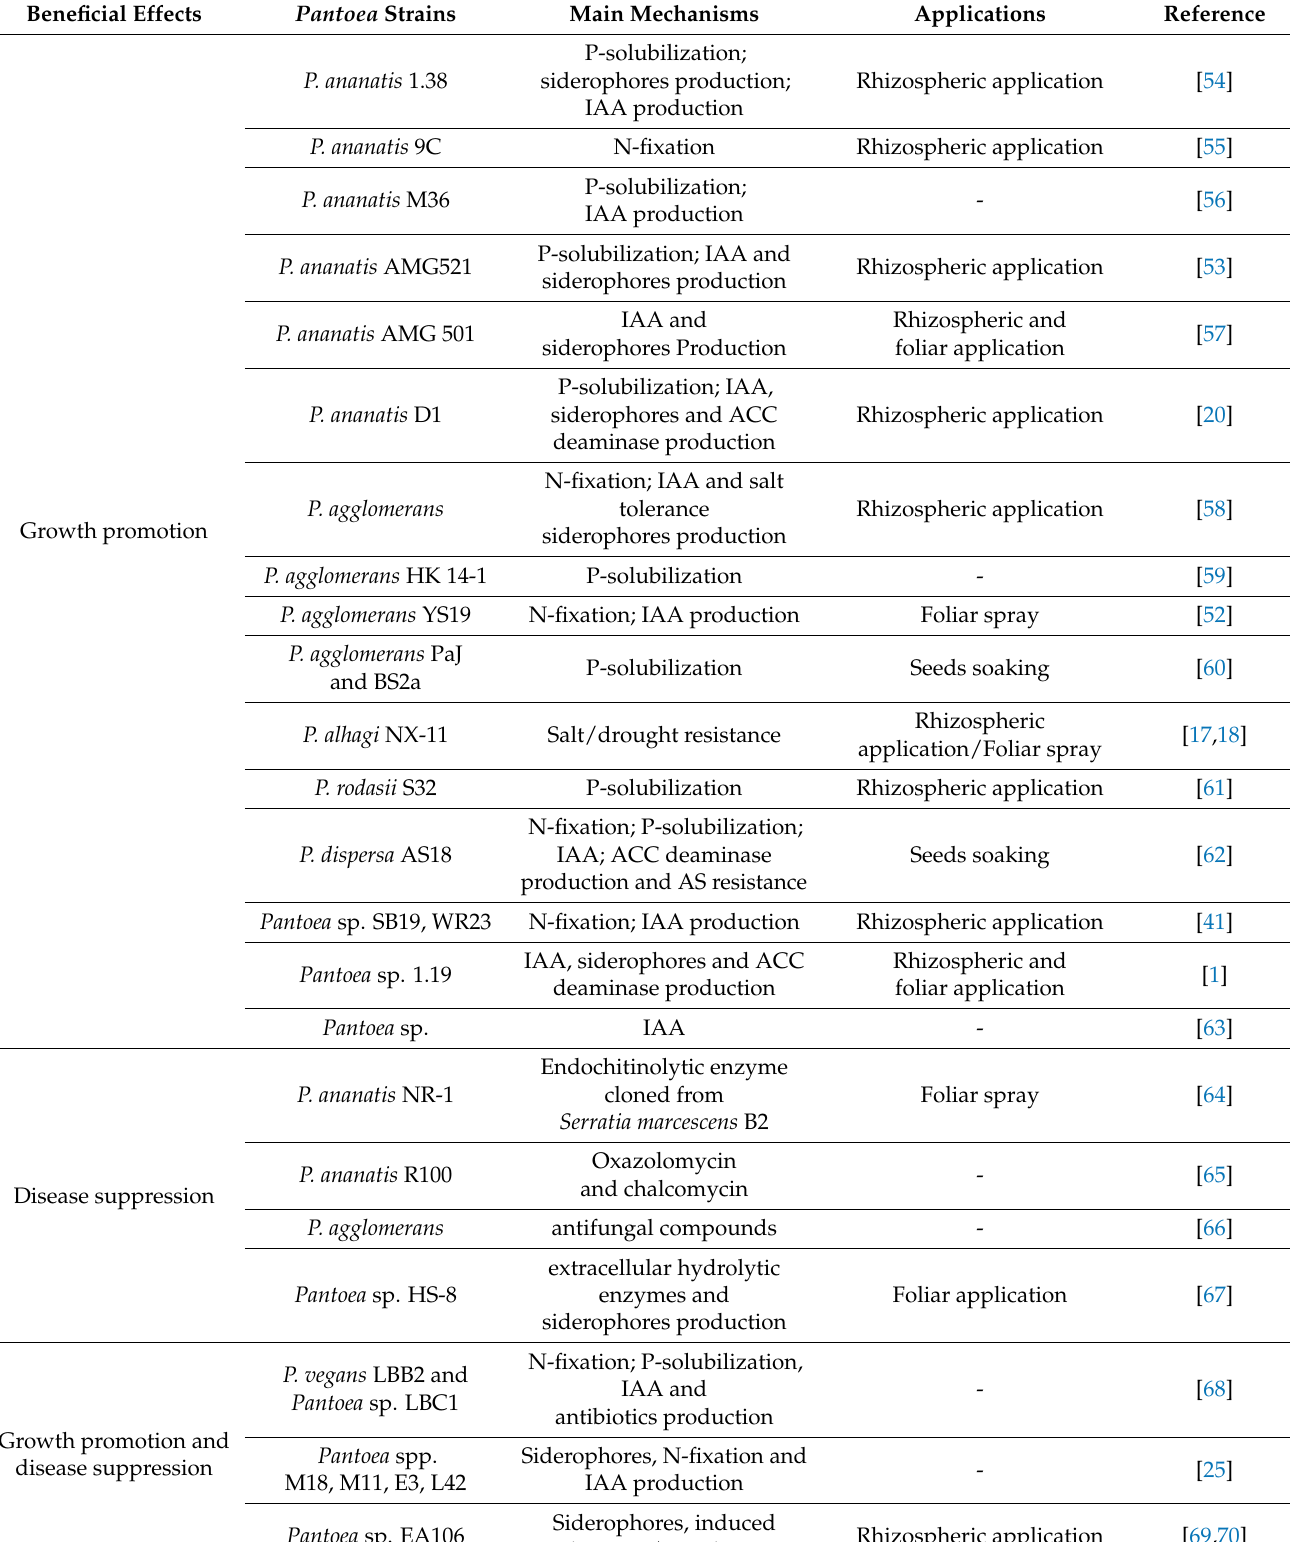
Table 1. Beneficial effect of Pantoea species in rice growth promotion and disease